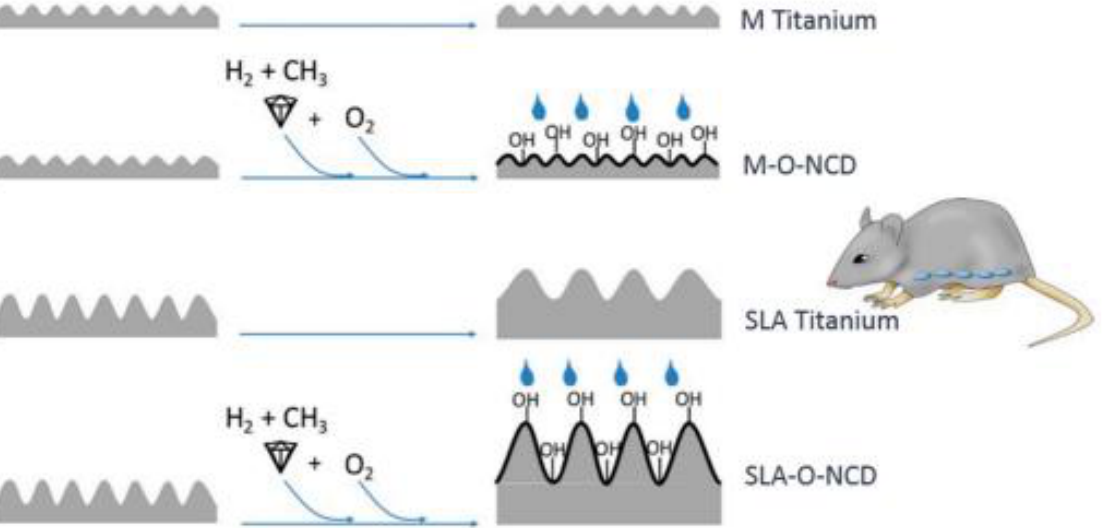
Figure 6. A design showing four different surfaces with different levels of roughness and different hydrophilicity achieved through additional nanosized diamond coatings; M Titanium: machined Titanium; M-O-NCD: O-terminated nanocrystalline diamond on machined Titanium; SLA Titanium: sand blasted and acid-etched Titanium; SLA-O-NCD: O-terminated nanocrystalline diamond on sand blasted and acid-etched Titanium (From Ref. [106])